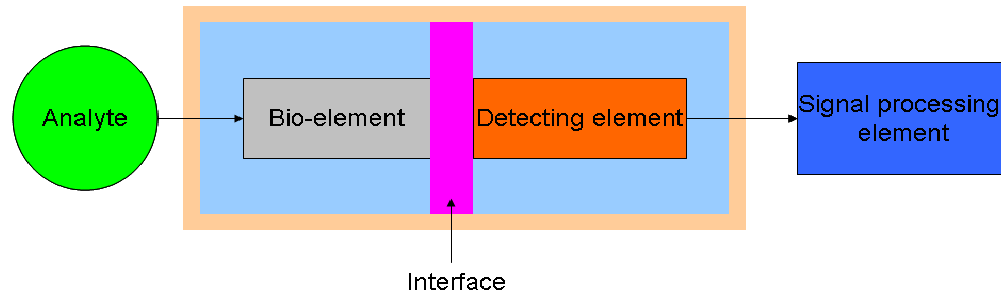
Figure 1. Schematic representation of the basic concept of a biosensor (adapted from